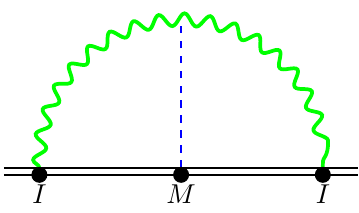
Figure 2 . Self-energy diagram of the next-to-leading order process involving the scattering of modes emitted by a radiative multipole source I onto a mode generated by a generic multipole M